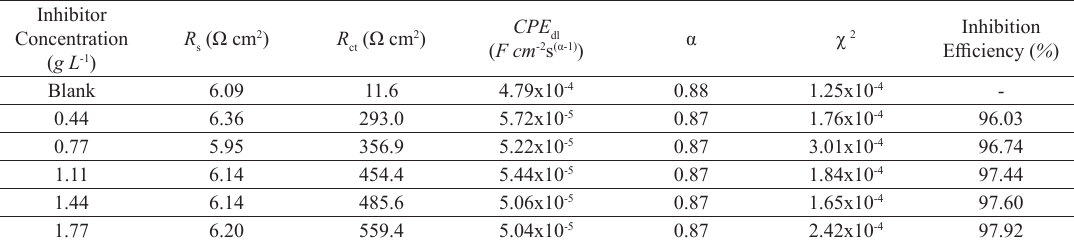
Table 4. Electrochemical parameters obtained through the system electrical equivalent circuit in 0.5 mol L -1 HCl. Inhibitor Concentration ( g L -1